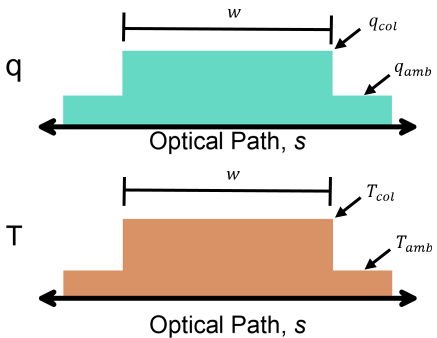
Figure 3. Column distribution of temperature and H 2 O volume fraction used to generate theoretical spectra for comparison with measured data. T amb and q amb represent the ambient temperature and H 2 O volume fraction in the facility and T col and q col are the elevated temperature and H 2 O volume fraction of the combustion products in the